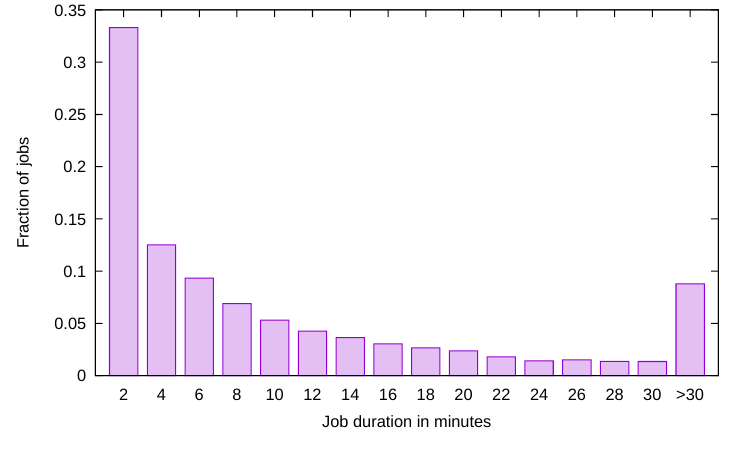
Figure 1. Distribution of job